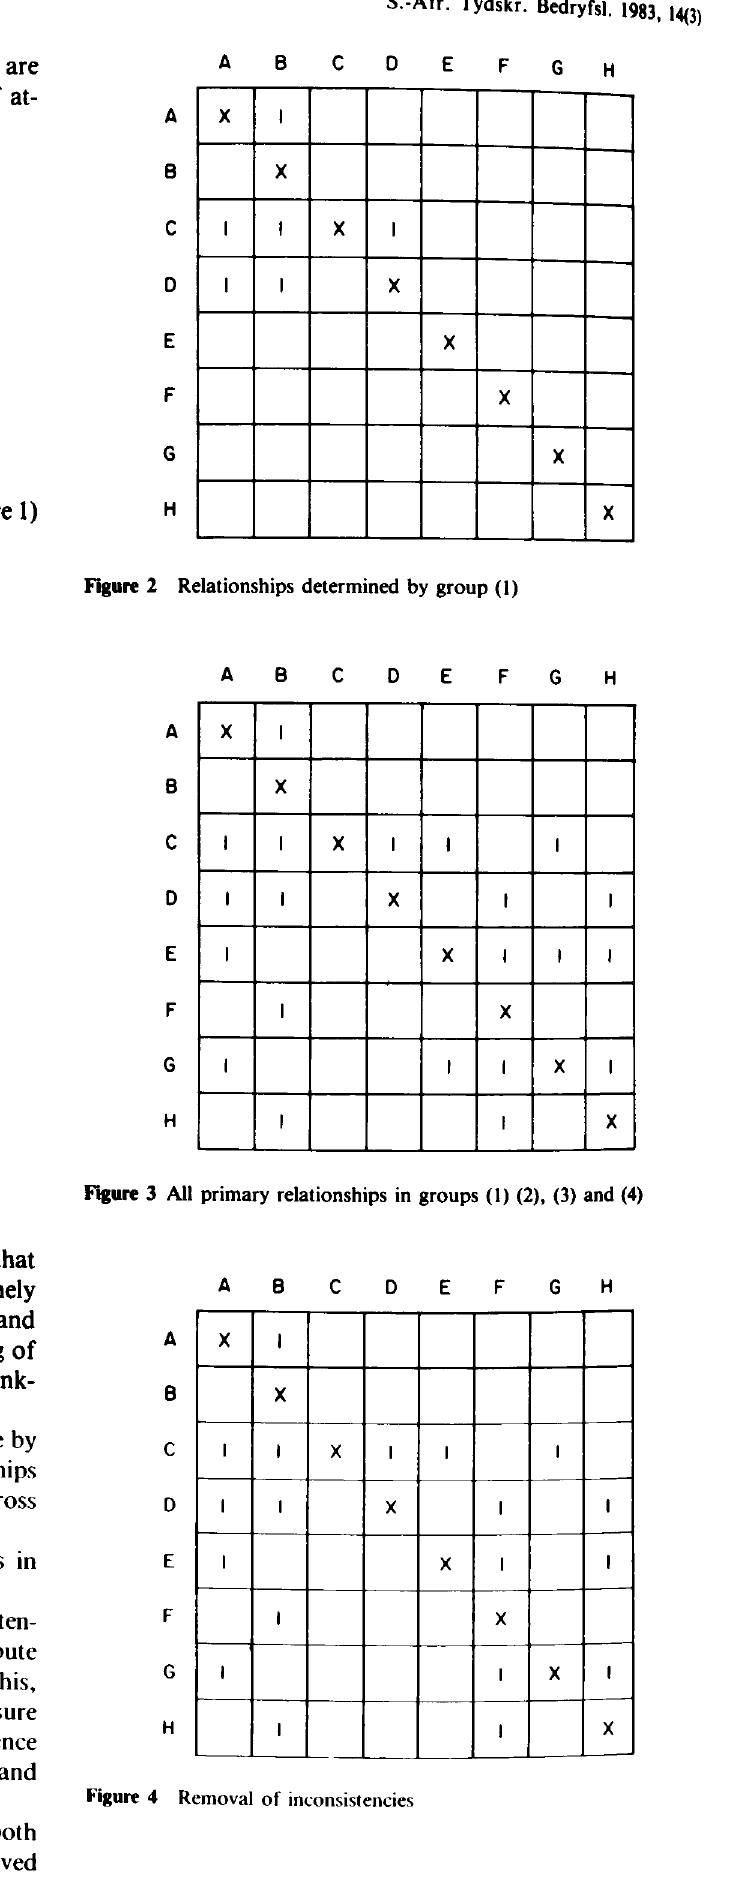
Figure 4 Removal of